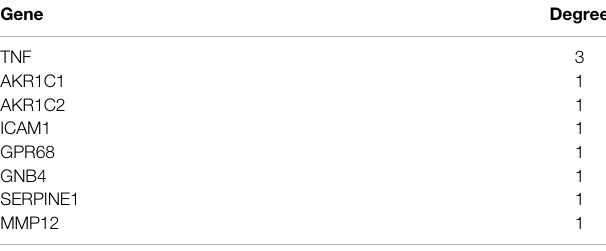
TABLE 5 | Protein-protein interaction network analysis for differential expressed genes in ESCC samples based on connectivity degrees evaluation. Gene Degree